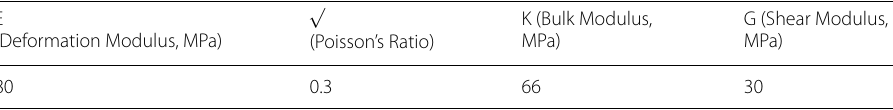
Table 10 Bulk, shear and deformation